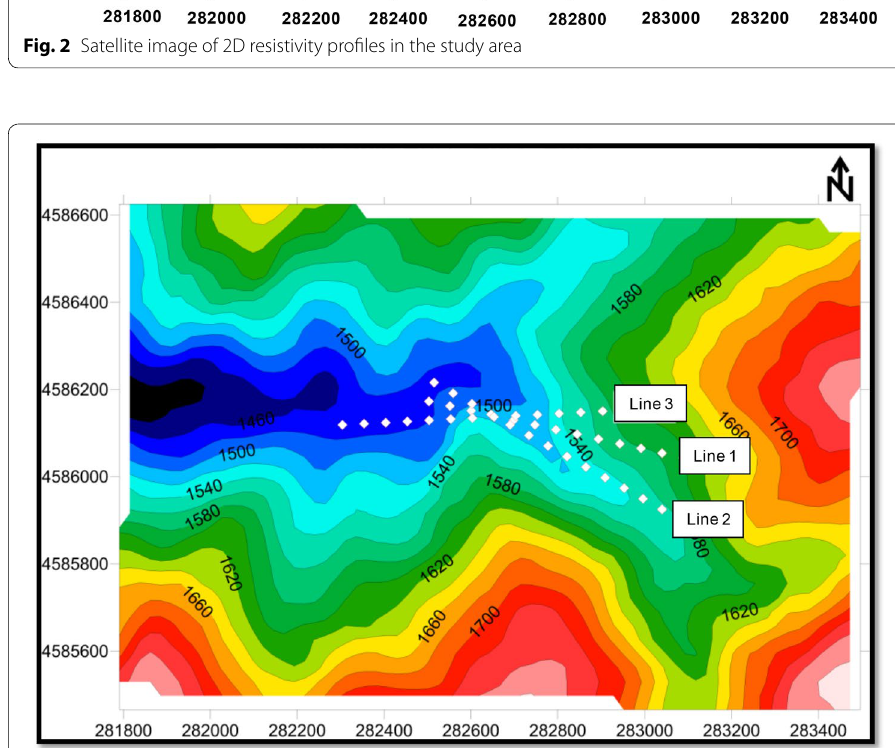
Fig. 3 The appearance of 2D resistivity lines on topography